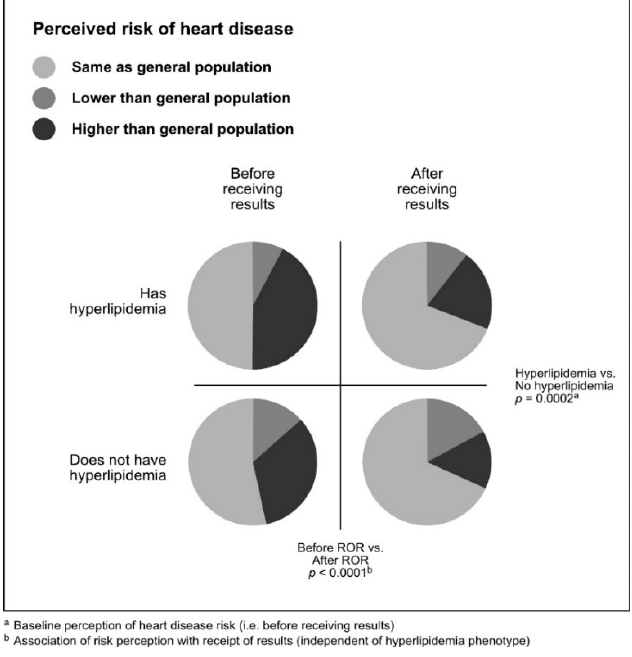
Figure 2. Perceived risk of heart disease in participants with and without hyperlipidemia before and after receiving results.